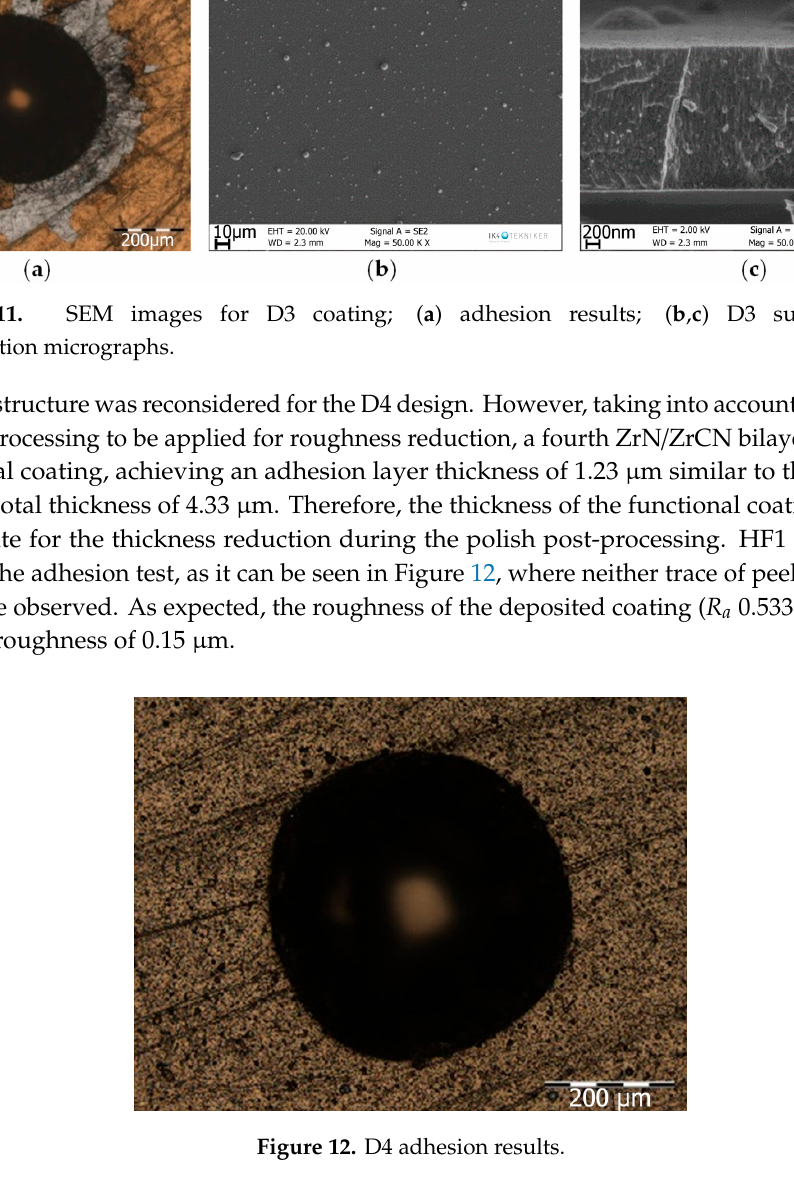
Table 7. Polish post-processing results.